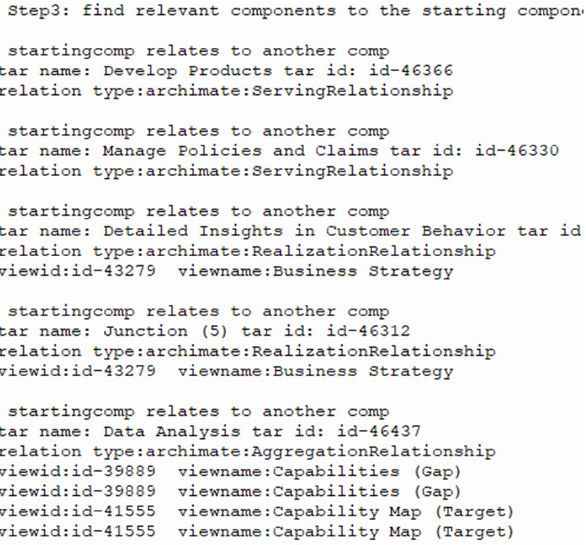
Figure 7. Sample code snippets for automatic slicing in Python.